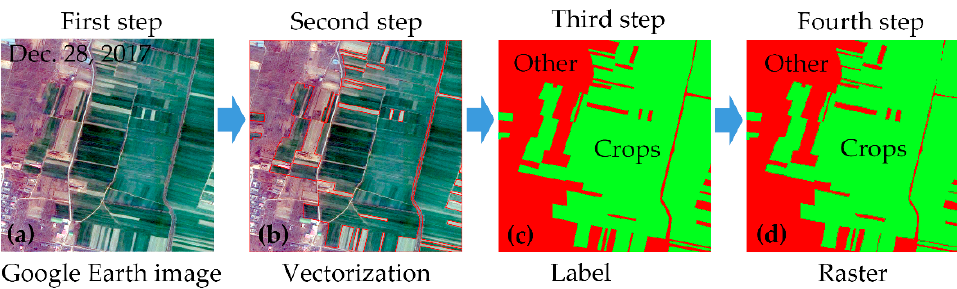
Figure 4. Flow diagram for validation data production. ( a ) the Google Earth image with a spatial resolution of 1 m. ( b ) the results of vectorization and the red line is the boundaries of the surface features. ( c ) the results for identifying the attributes of vector polygons. ( d ) the raster converted from these vector polygons.